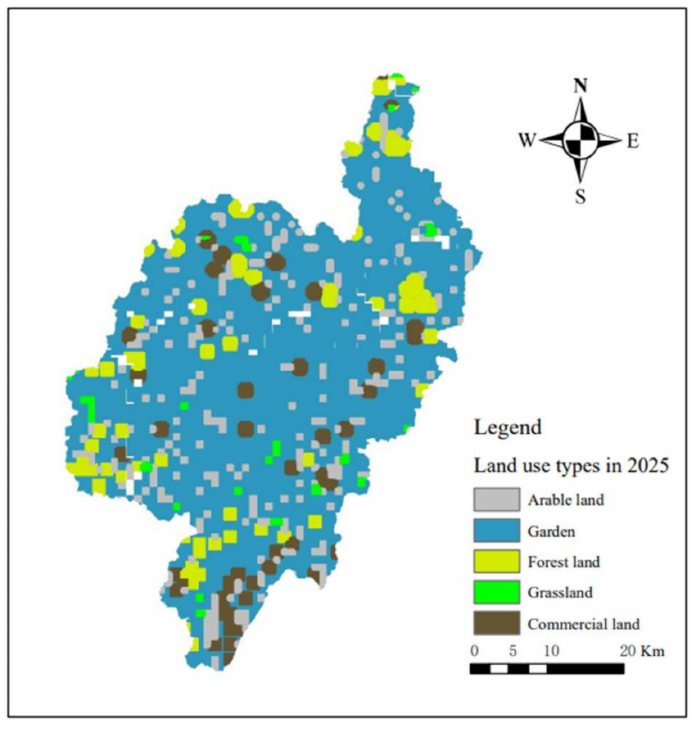
Figure 9. Land use map in